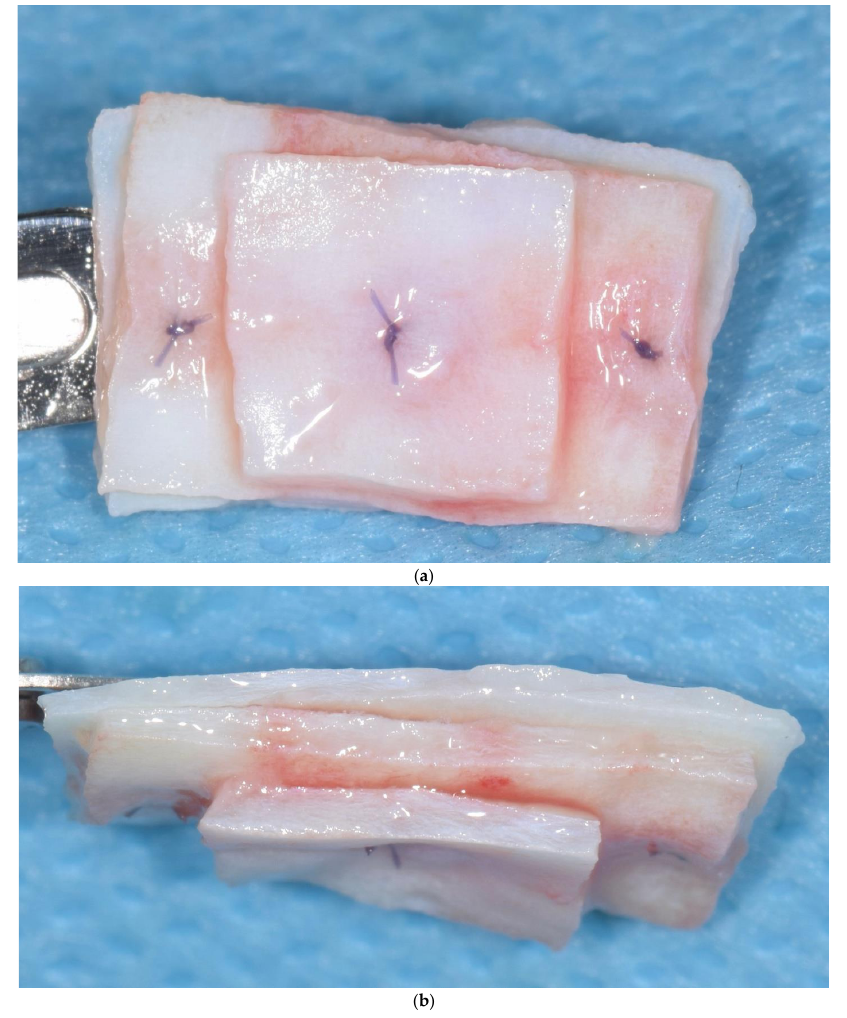
Figure 3. ( a , b ) A new PDXCM (NovoMatrix TM ; BioHorizons, Birmingnam, USA) was used, with an inlay technique. The PDXCM can be sectioned and aggregated in multiple layers sutured to each other in one unique inlay graft ready to be placed on the bleeding bed around the implant and fixed to the periosteum and/or to the flap.